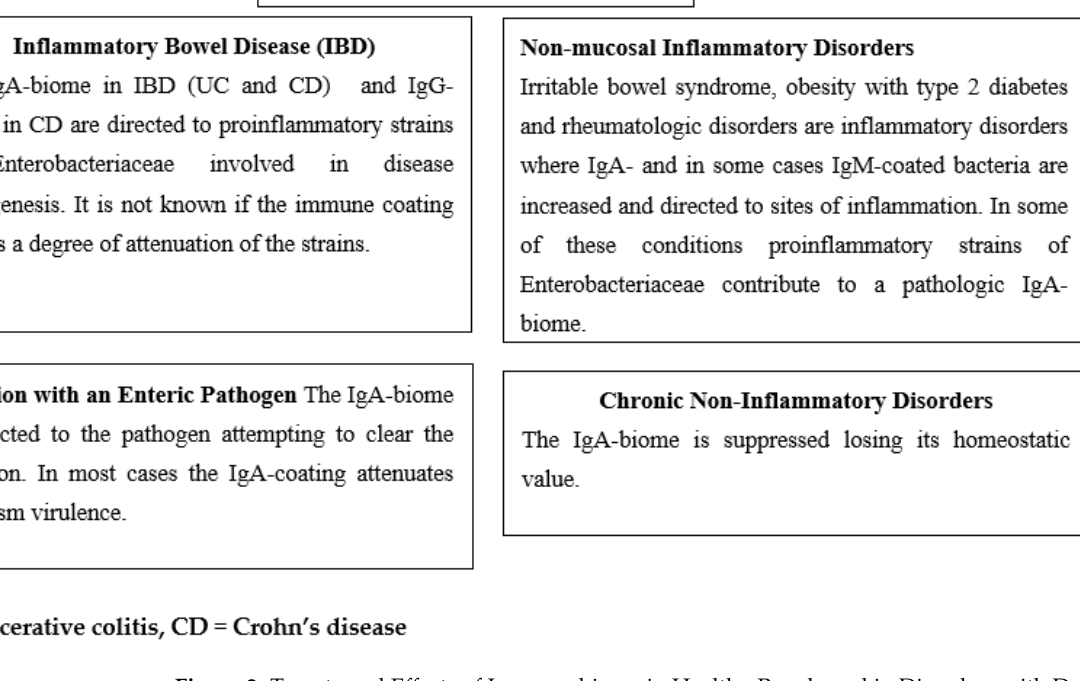
Figure 2. Targets and Effects of Immune-biome in Healthy People and in Disorders with